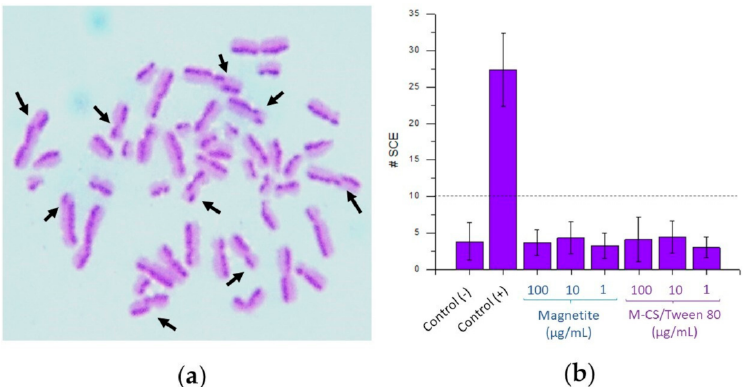
Figure 10. Sister chromatid exchange (SCE) analysis of lymphocytes exposed to microspheres. ( a ) An SCE positive sample (mitomycin C). The exchanges between one sister chromatid to another are witnessed because of the color. ( b ) The number of SCE found in all the samples.